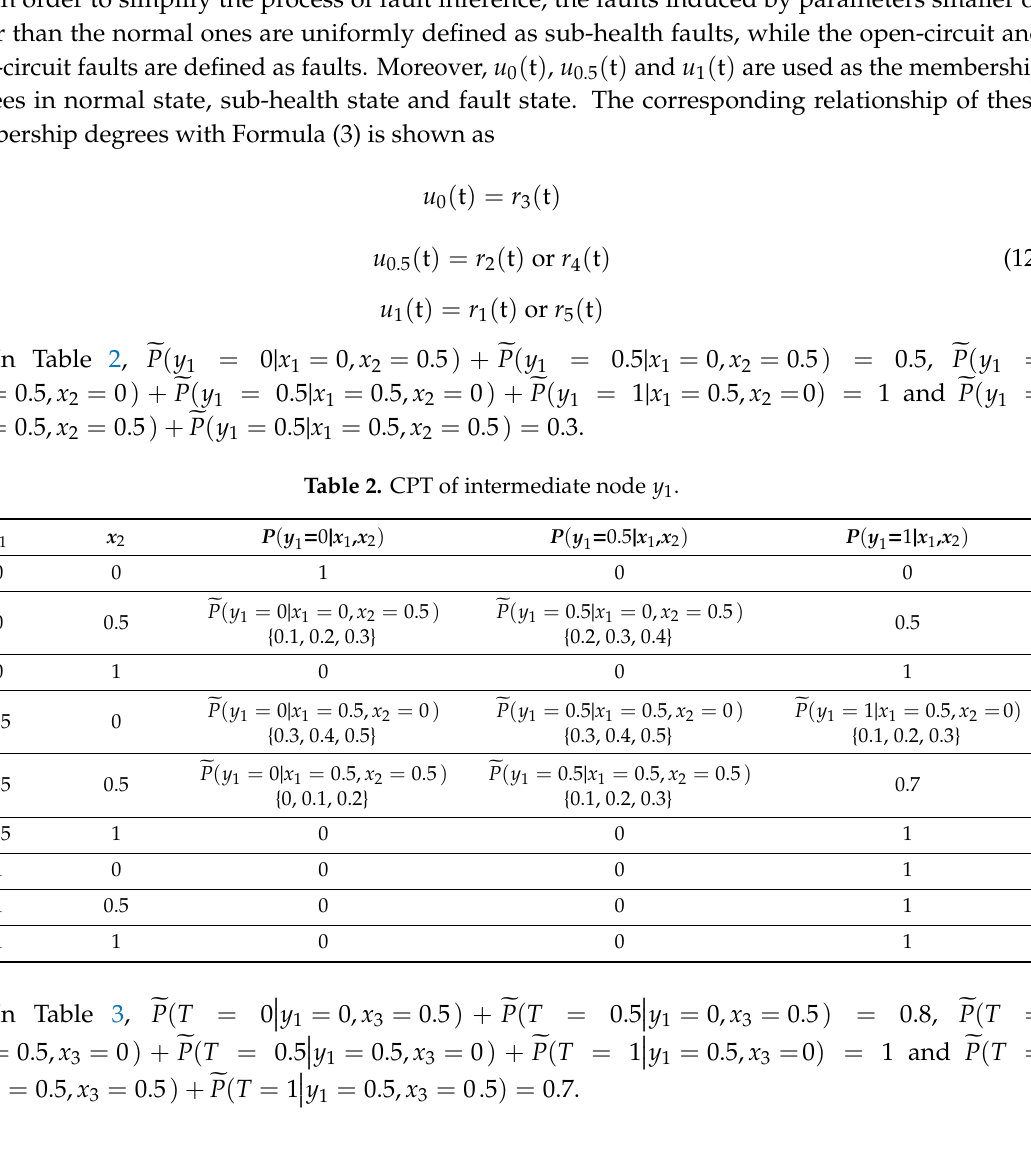
Figure 5. BN of faults of medium- and low-frequency units.